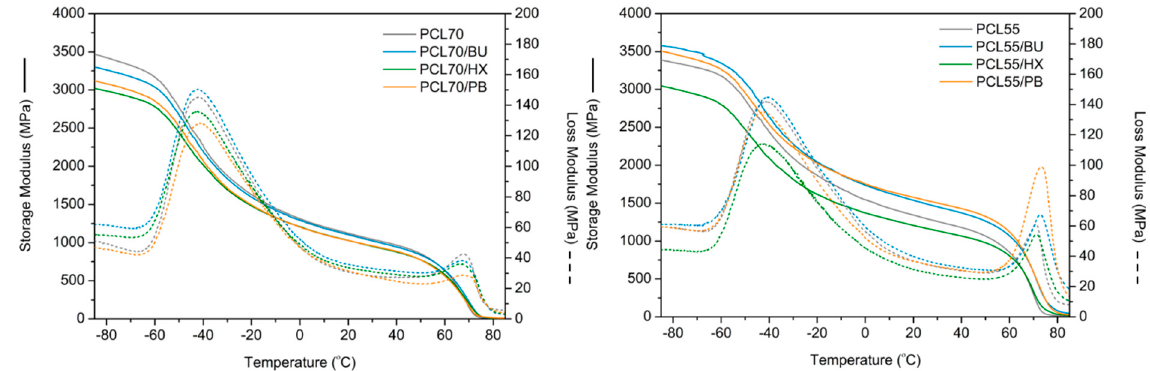
Figure 6. Storage and loss modulus for PCL/PLA blends (70/30) and (55/45).